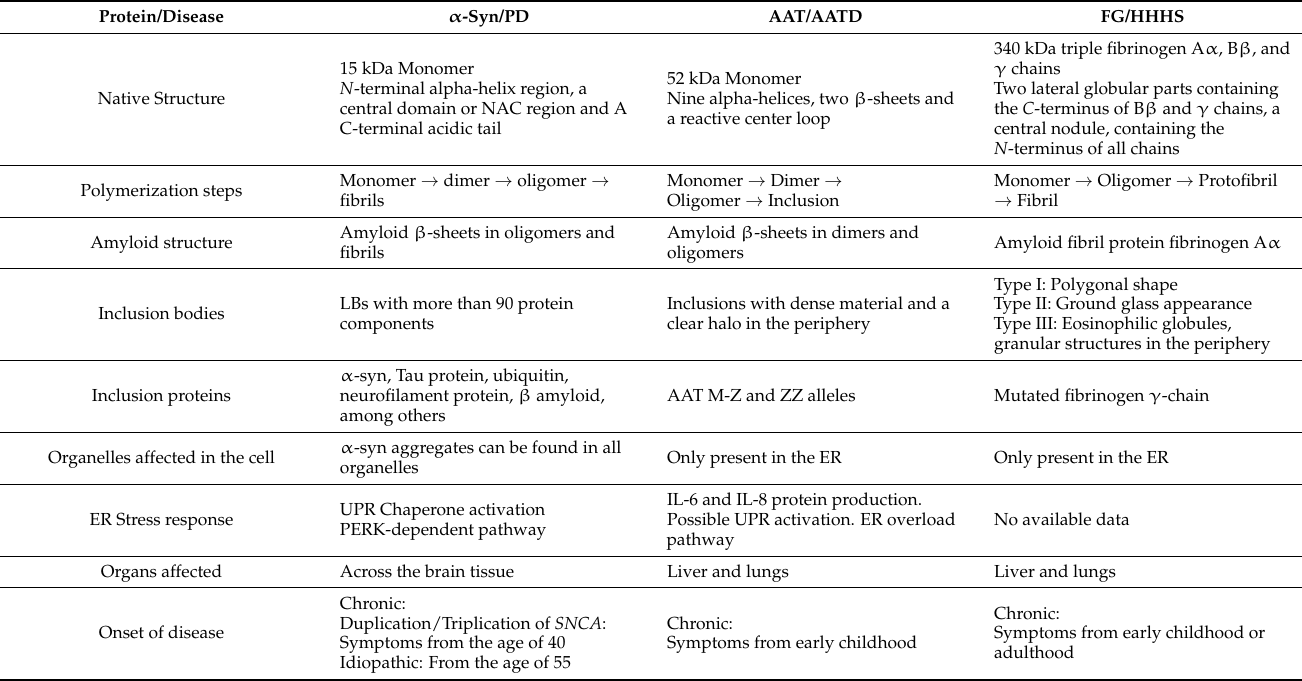
Table 1. Main comparison of aggregated proteins involved in PD, AATD, and HHHS.